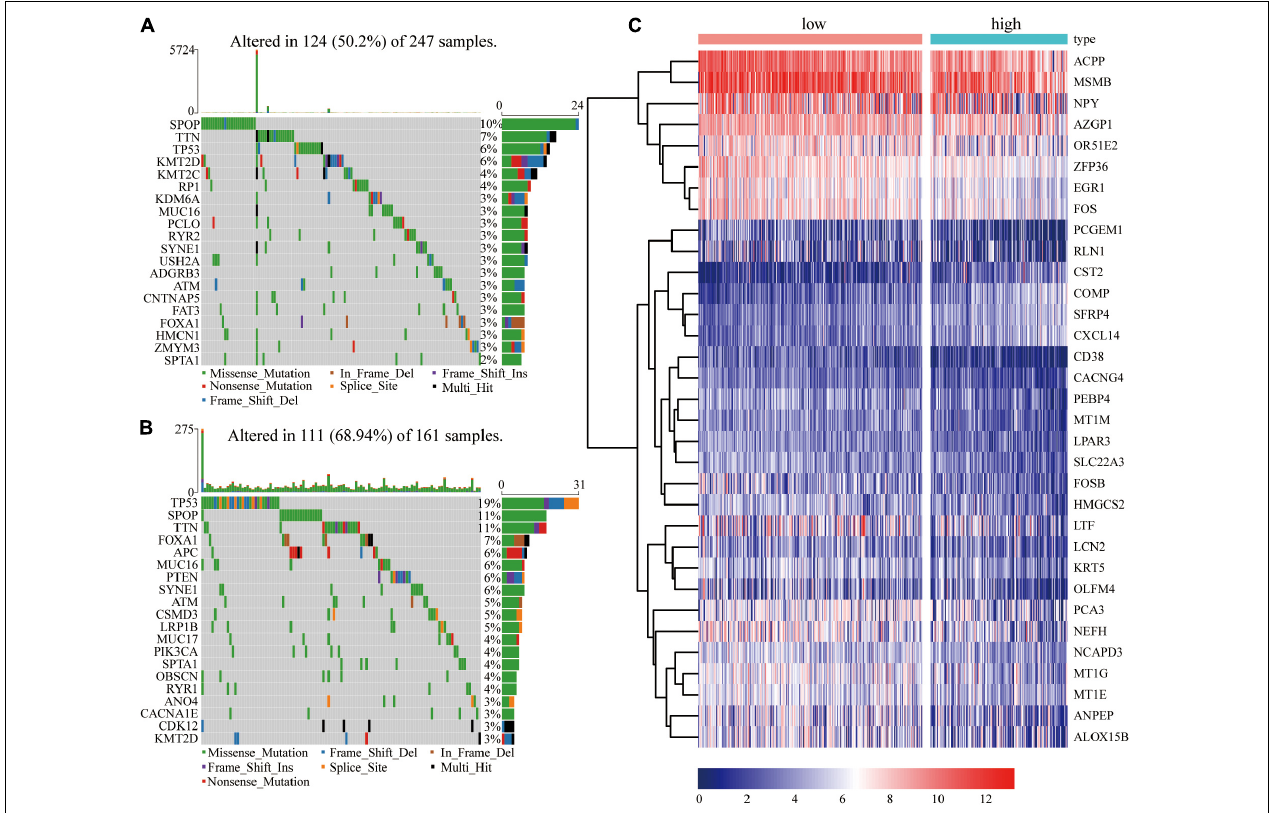
FIGURE 7 | Frequency of gene mutations and differential expression of genes in different risk groups. (A) Visualization of gene mutations in low-risk score groups; (B) Visualization of gene mutations in high-risk score groups; (C) Heatmap showing differential gene expressions in different groups.